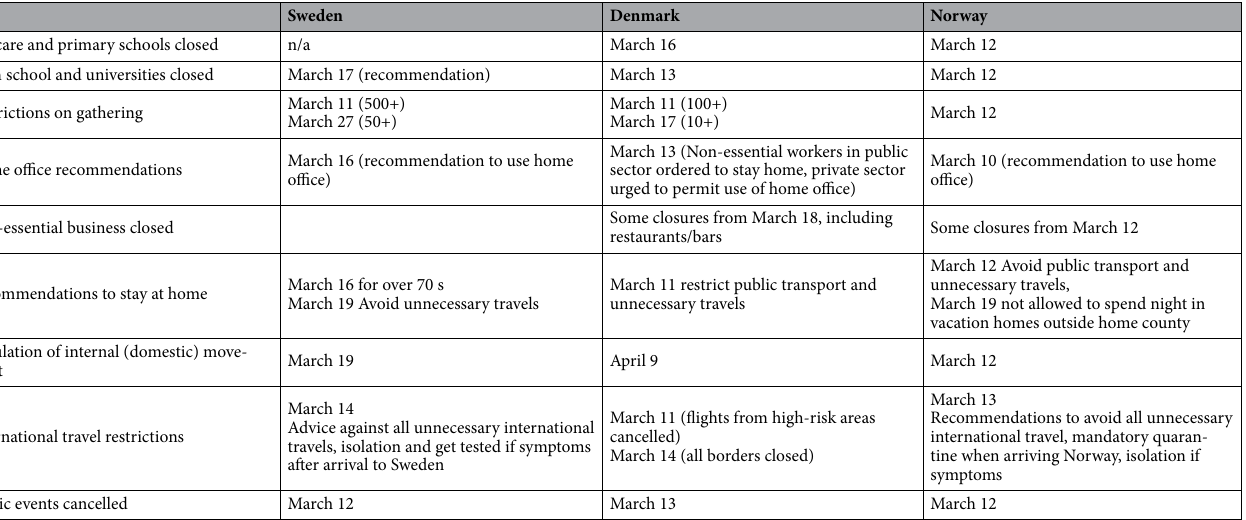
Table 1. Summary of early COVID-19 mitigation measures in Norway, Sweden and